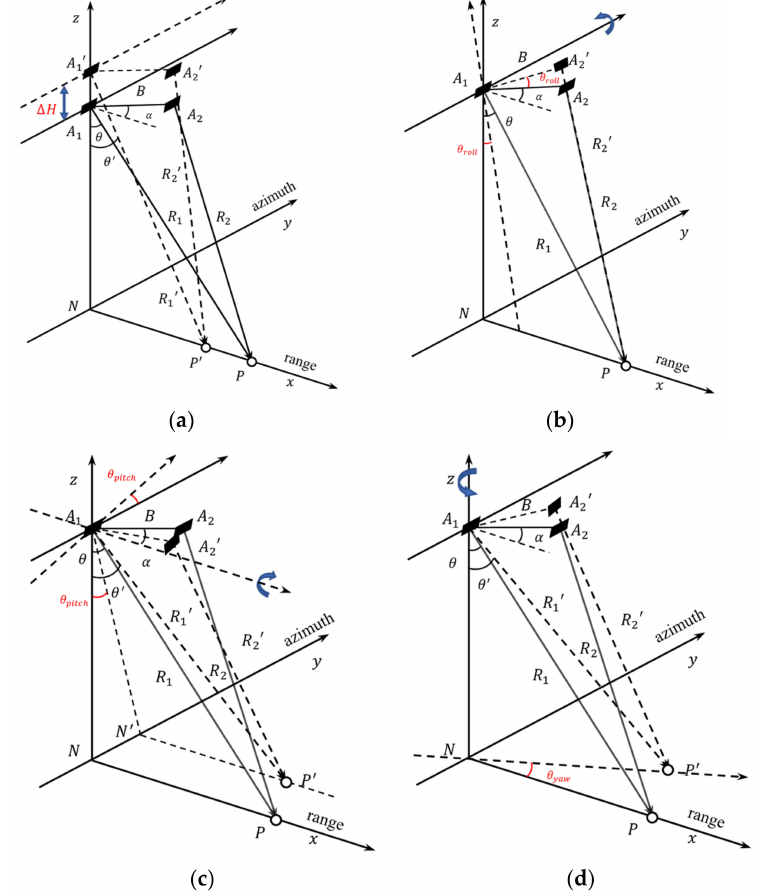
Figure 2. IRA geometry with four attitude errors. ( a ) Platform altitude error. ( b ) Roll error. ( c ) Pitch error. ( d ) Yaw